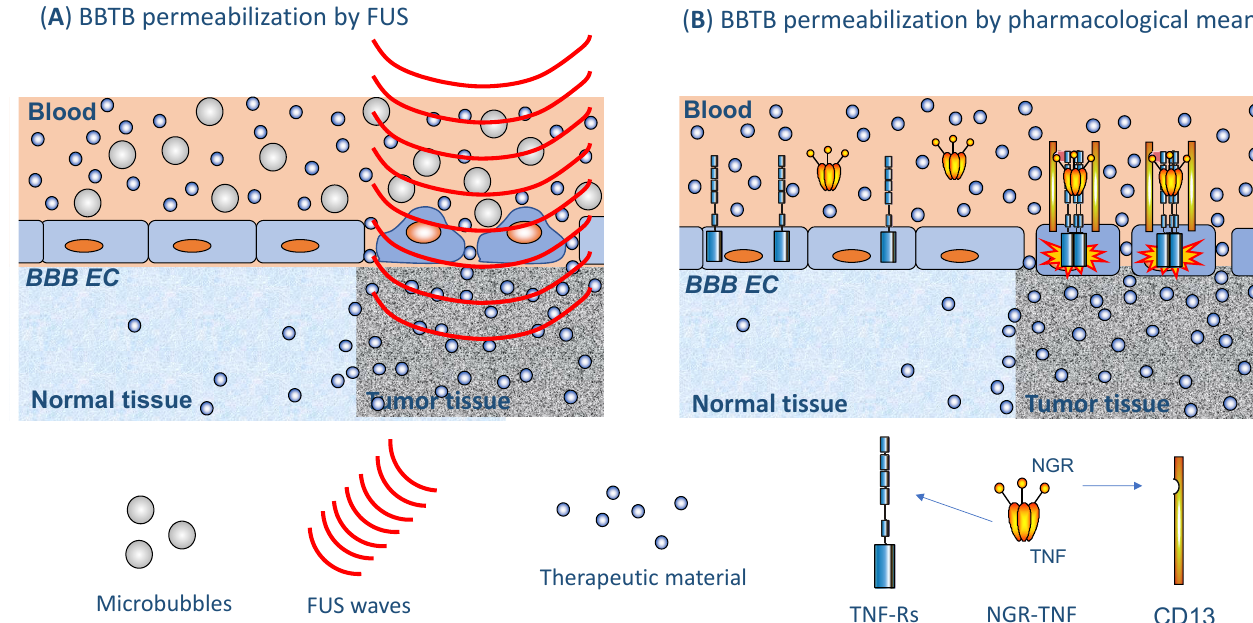
Figure 2. Drug delivery to the brain tumors through permeabilization of the BBTB. This figure shows two different approaches to enhance drug delivery through the BBTB. On the left side ( A ), permeabilization is achieved by means of focused ultrasound (FUS) in combination with microbubbles. It is the ultrasound (US) focusing that endows this approach with selectivity for the BBTB at desired sites of the brain. On the right side ( B ), permeabilization is achieved by means of a pharmacologically active compound that exerts its effect through disruption of TJs (e.g., NGR-TNF, a peptide-TNF fusion product that targets CD13-positive tumor vasculature), optimally only on endothelial cells of the